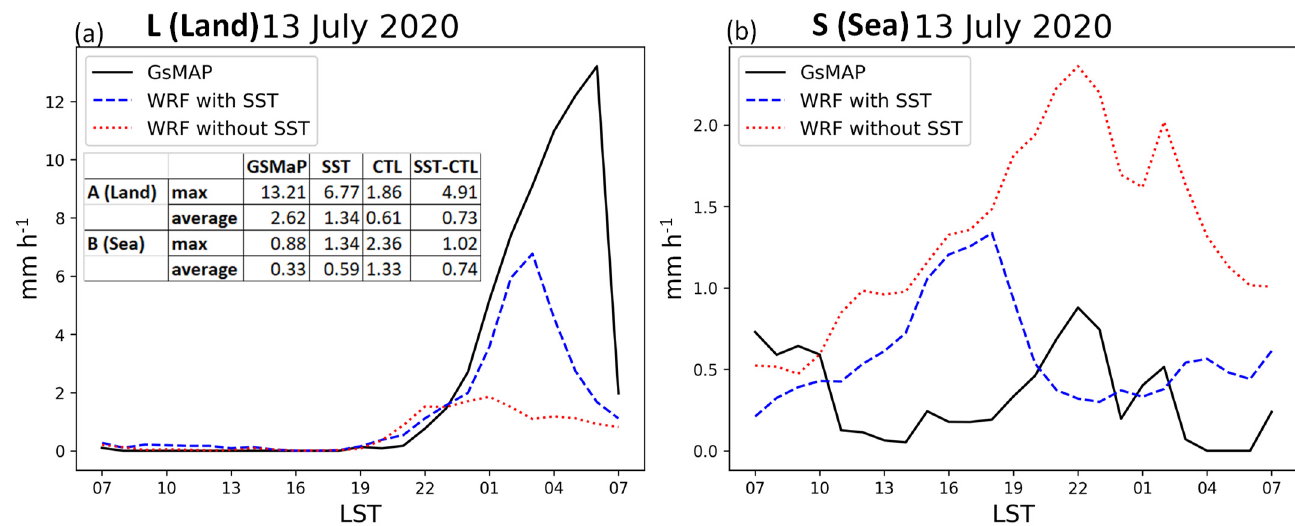
Figure 6. Comparison of simulated diurnal rainfall at D03 (1 km) resolution with GSMaP satellite for ( a ) rainfall over land (A, 1° S–Eq, 119° E–121° E); ( b ) rainfall over sea (B, 3° S–1° S; 124 ° –126° E). The diurnal cycles of rainfall during 13–14 July 2020 are averaged over A and B areas, as shown previously in Figure 5.